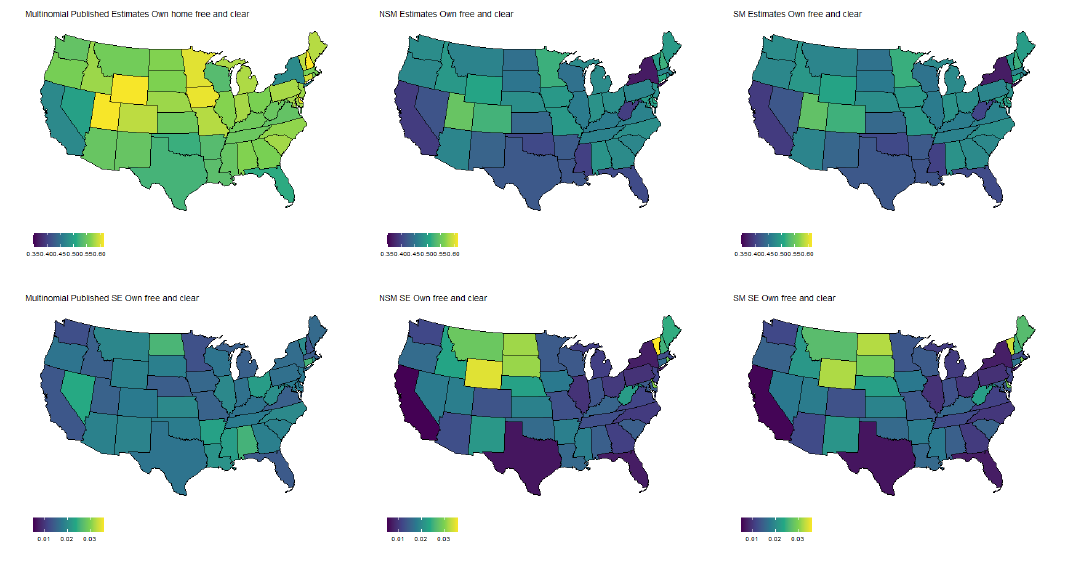
Figure 5. Estimated population proportion of people who own their home free and clear by state and estimator along with corresponding standard error in Week 1 of the Household Pulse Survey. Estimates are plotted on the same color scale, and SEs are plotted on another color scale.